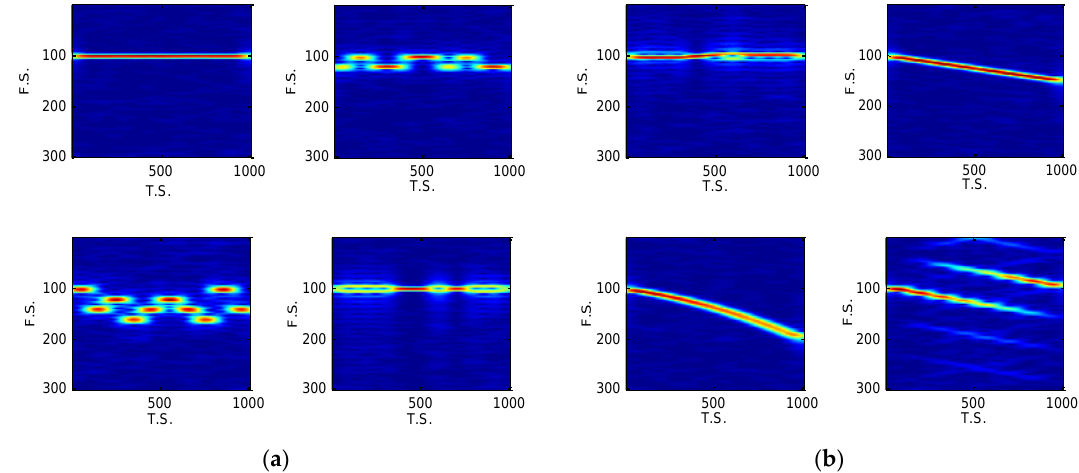
Figure 2. The image displays the TFD of eight type signals at 20 dB: ( a ) STFT of NS, BFSK, QFSK and BPSK; ( b ) STFT of QPSK, LFM, NLFM and FRANK.